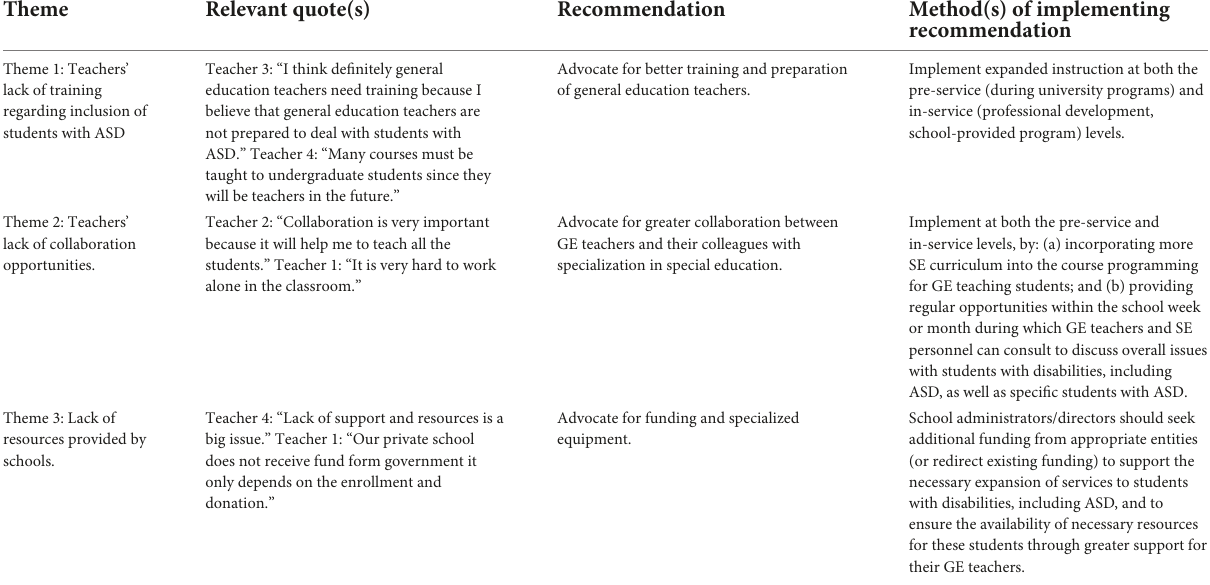
TABLE 2 Presentation of themes and related